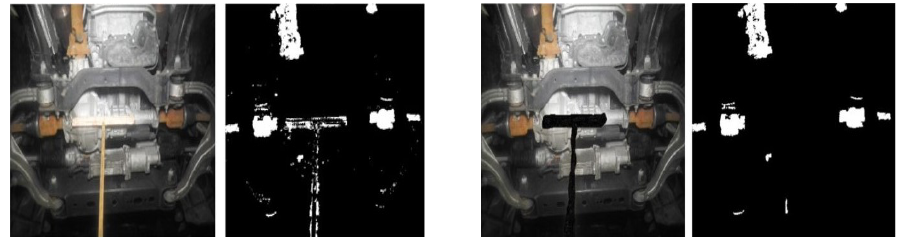
Figure 9. Illustration of corrosion detection in sample images from dataset 1 ( left ) and dataset 2 ( right